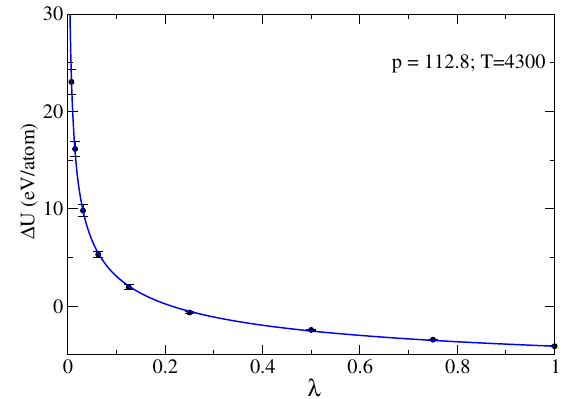
FIG. 1. The integrand of Eq. (11) evaluated at several values of λ for the FeO case reported in Table II. The data are fitted to the function f ð λ Þ ¼ a λ − k þ b (blue line), with k ¼ 0 . 37 , a ¼ 5 . 34 , b ¼ − 9 . 45